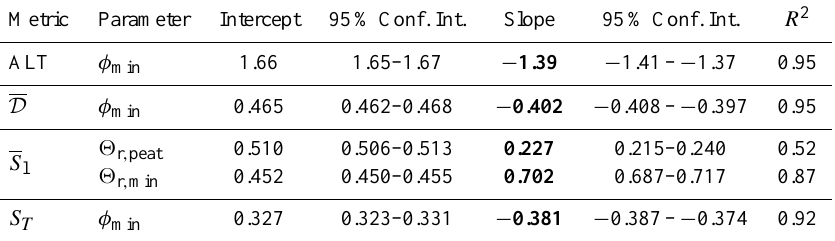
Table 2. Linear regression intercept and slope coefficients for permafrost metrics as a function of calibration-constrained parameters